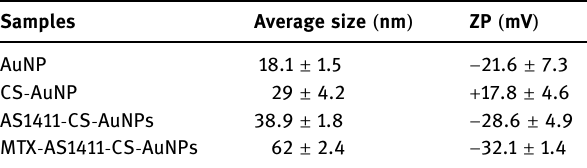
Table 2: The average size and ZP of AuNPs, CS - AuNPs, AS1411 - CS - AuNPs, and MTX - AS1411 - CS - AuNPs